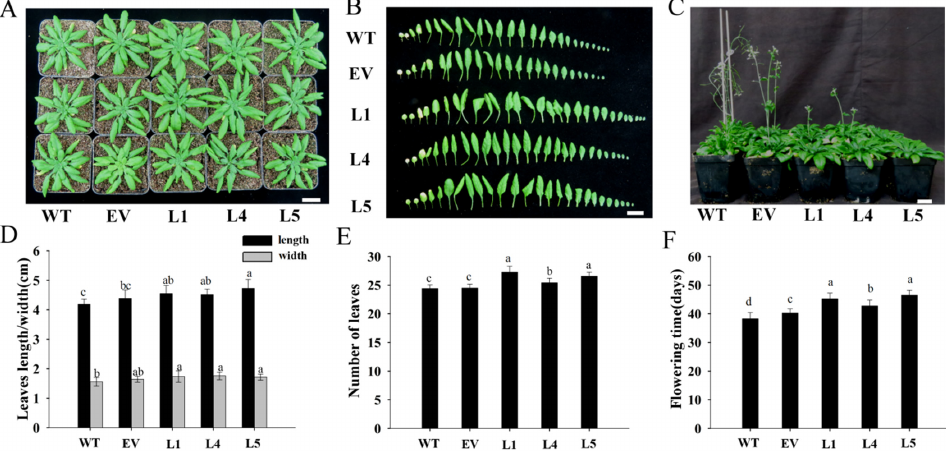
Figure 6. Phenotypes of MeNINV1 transgenic Arabidopsis and their controls. ( A ) Phenotypes of plants. ( B ) Morphology of leaves per plant. ( C ) Flowering initials. ( D ) The length and width of the longest leaves. ( E ) The numbers per plant. ( F ) Flowering time of the plants. L1, L4, and L5 are MeNINV1 transgenic Arabidopsis lines. EV is a pCAMBIA1300-GFP transgenic Arabidopsis line. WT is wild-type Arabidopsis . Plants in ( A , B , D , E ) are five weeks old; ( C , F ) are flowing initials. Data in ( D – F ) are the means of 20 leaves ( D ) or plants ( E , F ) with three independent assays. Significant differences were determined by one-way ANOVA followed by Duncan’s multiple range test at p < 0.05. Values labeled with different letters (a, b, and c) were significantly different. Bar in B = 2